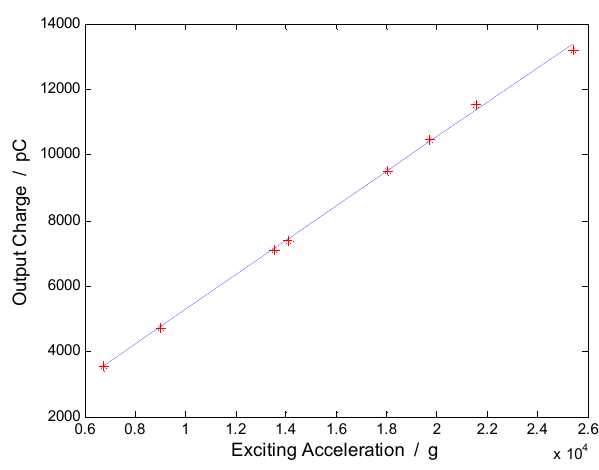
Figure 13. Fitted sensitivity curve of the calibrated accelerometer.